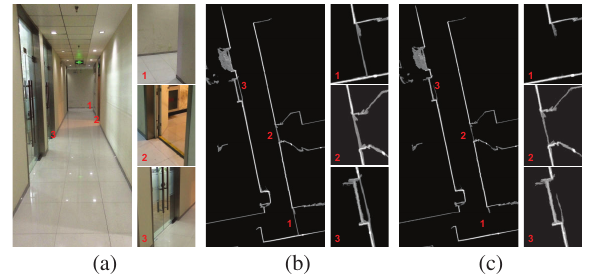
Figure 5: Comparative results of the traditional and our proposed contour-based likelihood generation approaches: (a) an indoor corridor scene with several sunk doors; (b) the last likelihood map generated by the traditional contour-slope model; (c) the last likelihood map generated by our proposed method. Brighter intensities indicate higher likelihood